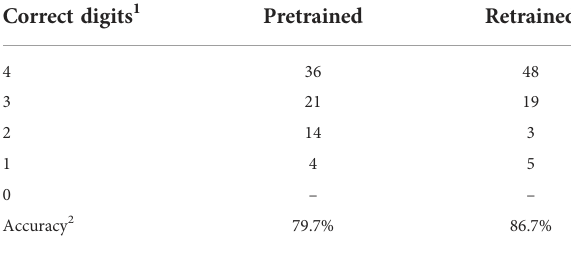
TABLE 1 Number of ear tag images with 0 to 4 correctly identi fi ed digits in the test set. Correct digits